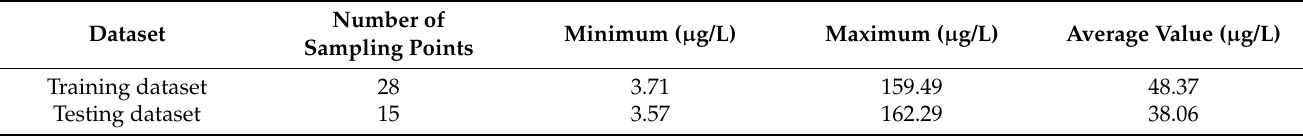
Table 2. The comparation of chlorophyll a concentration in datasets for modeling.